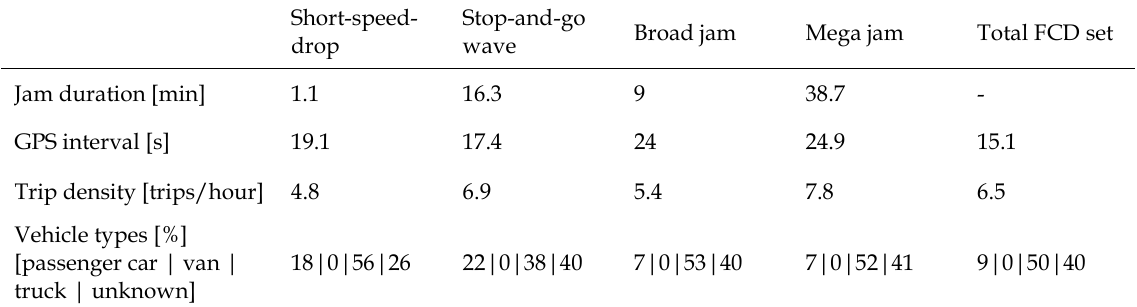
Average parameter values for different congestion